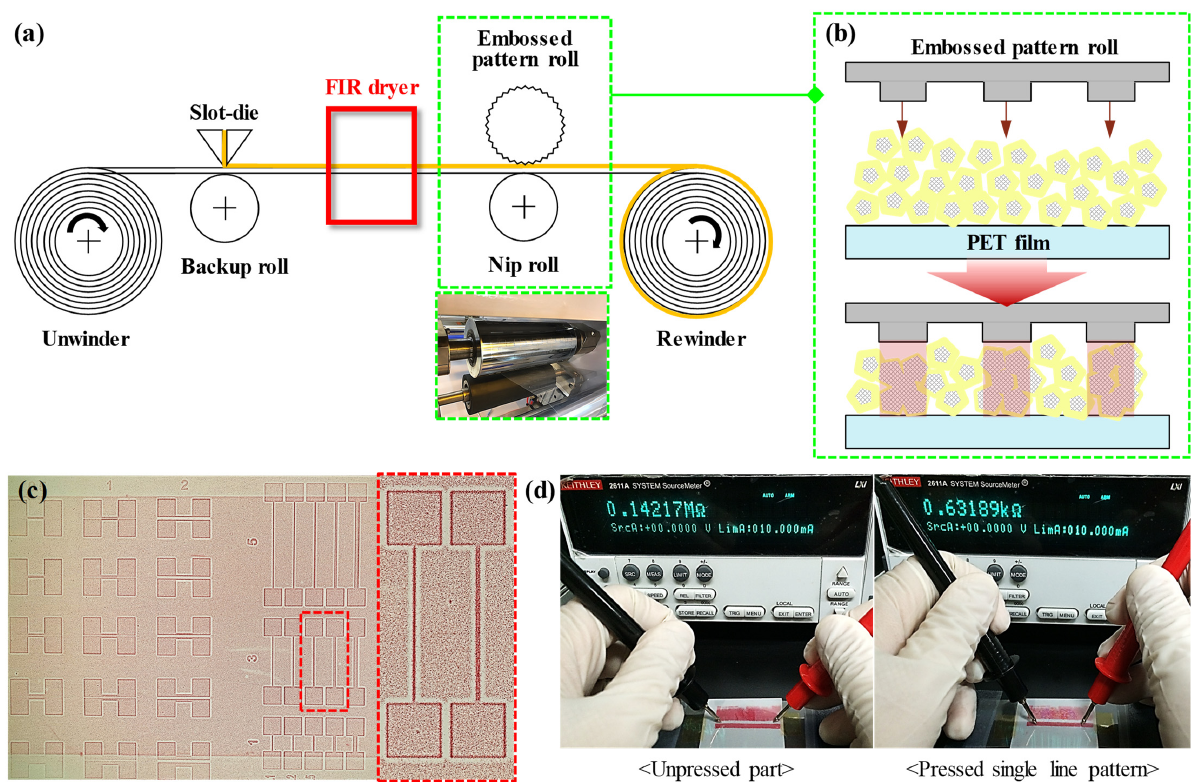
Figure 5. R2R-processed continuous patterning by selective calendering: ( a ) Schematic of concept for patterning process with R2R manufacturing and ( b ) selective calendering mechanism of PVP-Ag NW cTCF using an embossed pattern roll. ( c ) Pressure-sensitive paper pressed by an embossed pattern roll and ( d ) comparison of the resistance between the unpressed and pressed part in a single line pattern.